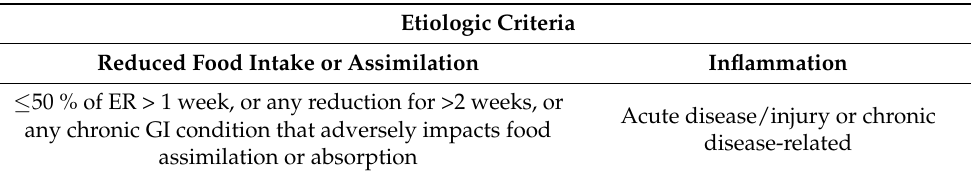
Table 2. Etiologic Criteria for malnutrition diagnosis.